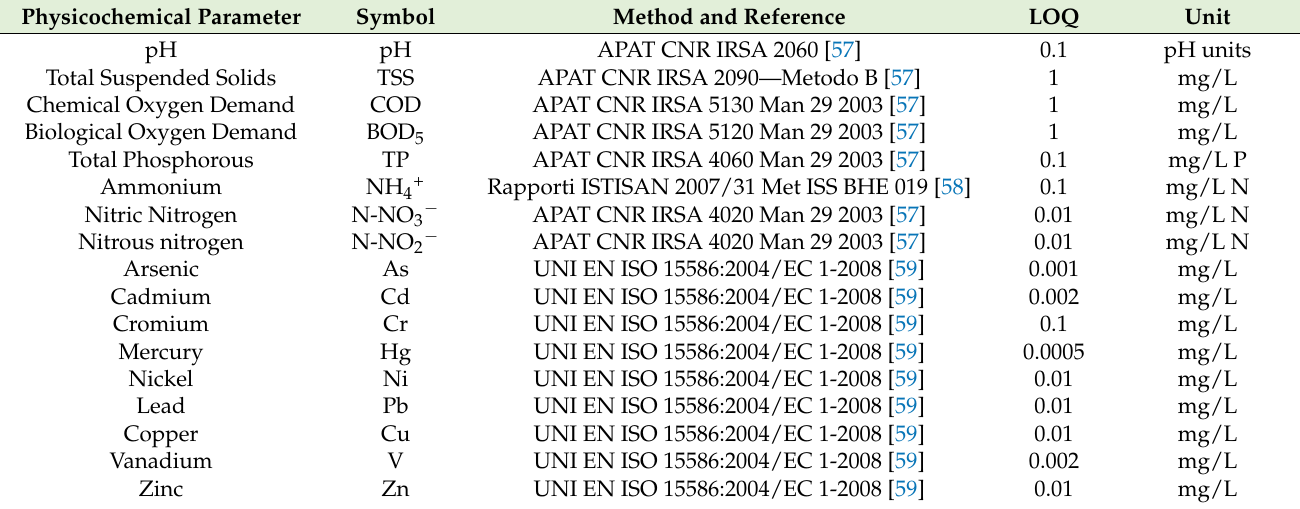
Table 2. Physicochemical analyses performed on powdered shells. In this table, method, limit of quantification (LOQ) and measurement units are reported for analyzed